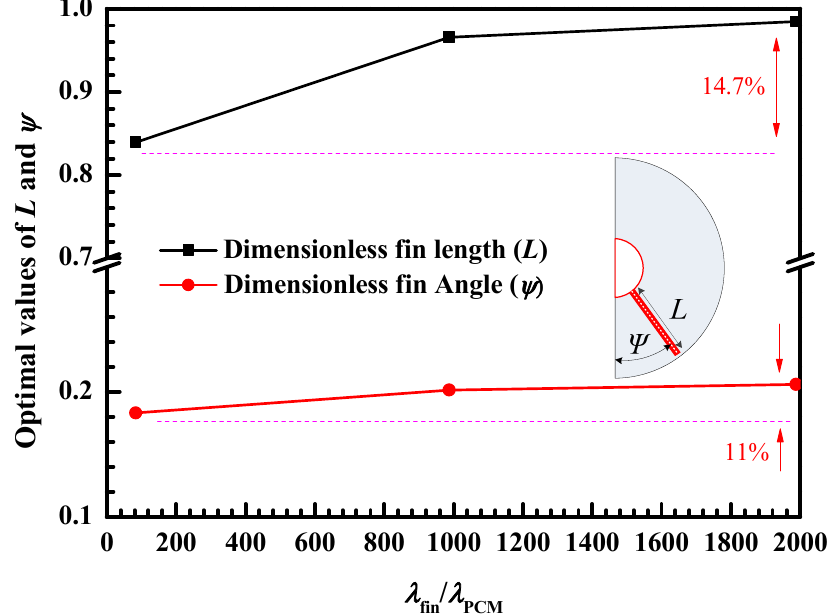
Figure 9. Variation of the optimal dimensionless fin length, L , and dimensionless fin angle, ψ , with the thermal conductivity ratio of fin to PCM ( λ fin / λ PCM ).